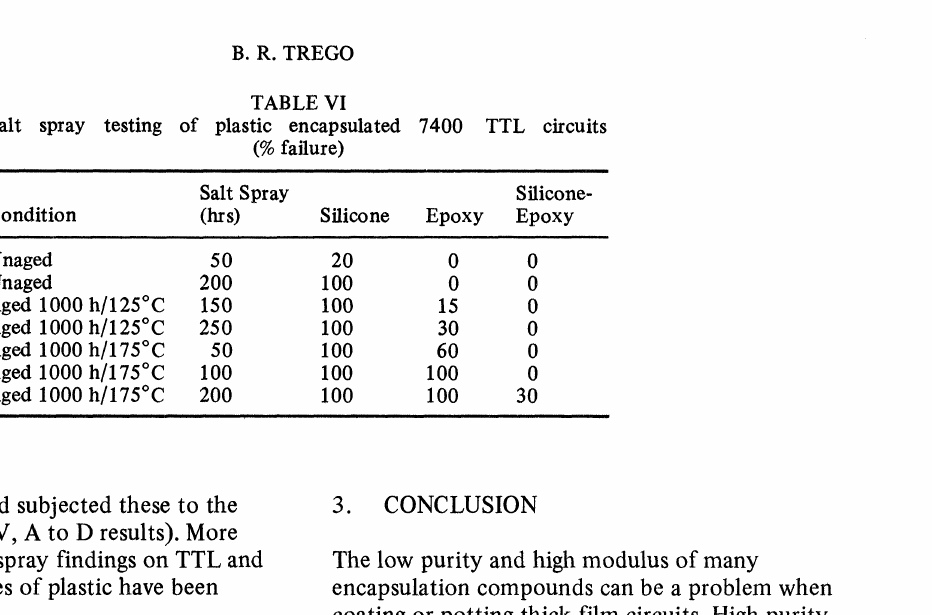
TABLE VI Salt spray testing of plastic encapsulated 7400 TTL